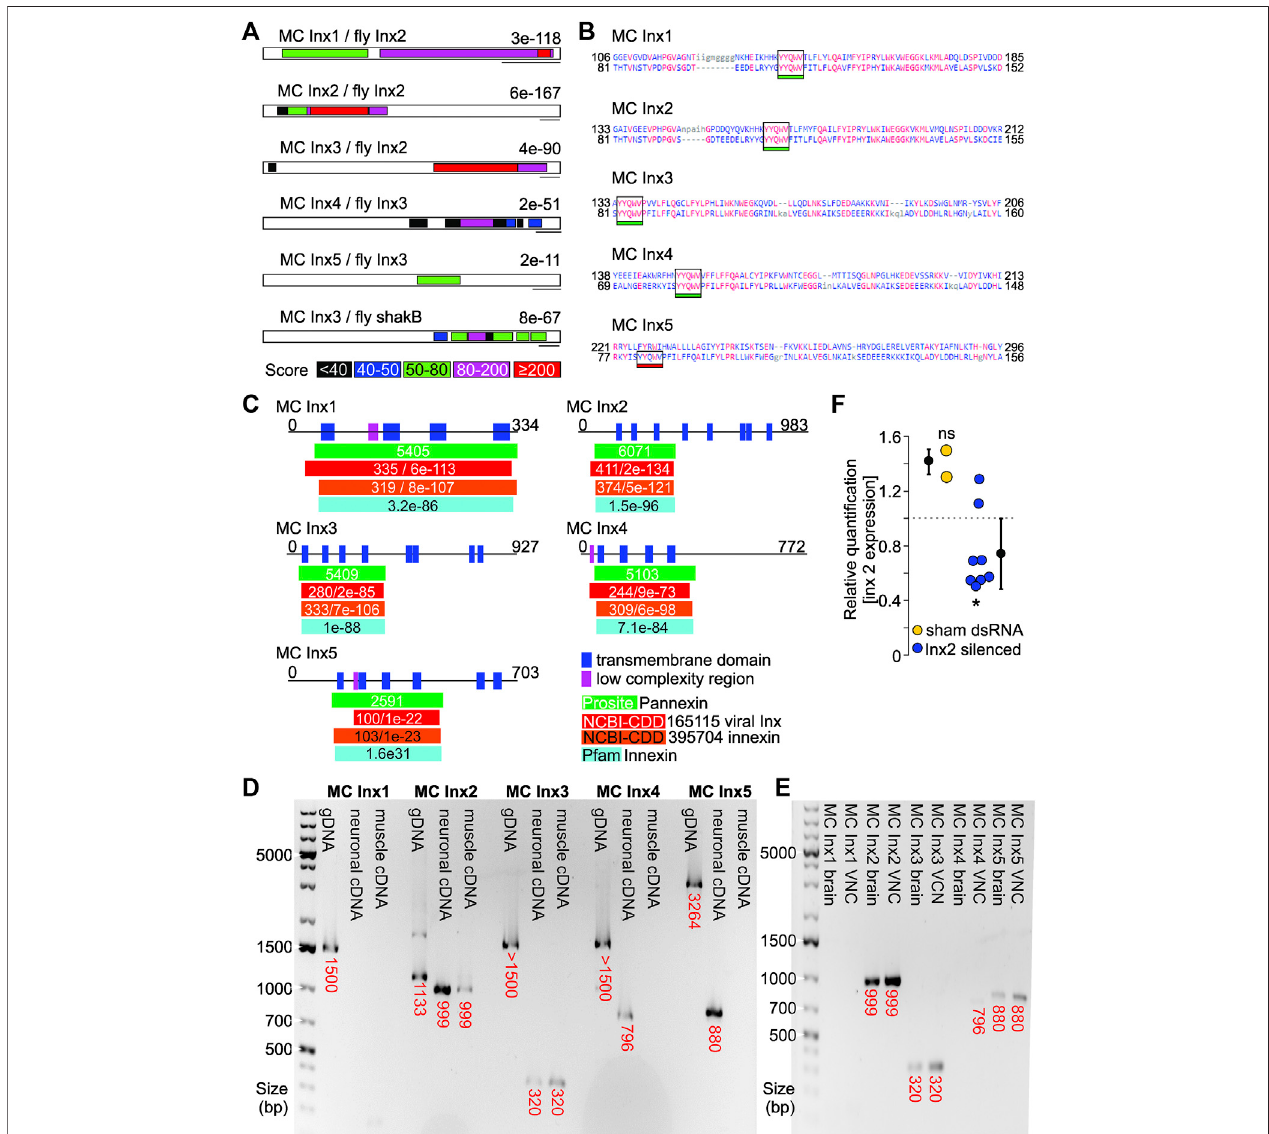
FIGURE 2 | (A) Blast comparison of marbled cray fi sh (MC) putative innexin transcripts and identi fi ed innexins from Drosophila melanogaster . E-values are given. Colors indicate score. Scale bars: 200 bp. (B) Amino acid projection of putative MC innexins (top) and innexin amino acid sequences of a domain model from other species (bottom). MC innexins 1-4 are predicted to contain the innexin hallmark YYQWV amino acid sequences. (C) Motif and domain prediction of putative MC innexin aminoacidsequences. All fi veinnexins containtransmembranedomains andinclude known innexinmotifs intheir aminoacidsequence (colored bars). (D) and (E) Gel electrophoresis of innexin sequences ampli fi ed using intron spanning PCR primers. (D) Innexins 2-5 had abundant expression in neuronal tissue. Innexins 2 and 3 were additionally expressed in muscle tissue. mRNA was extracted from neuronal tissue (brain, abdominal, and thoracic ganglia) and from abdominal muscles, respectively. (E) Innexins 2, 3, and 5 showed abundant expression in the brain. Innexins 2, 3, 4, and 5 were expressed in the ventral nerve cord. (F) RNAi-induced reductionofMCinnexin2,2 daysaftertreatmentwithdsRNA.ScrambleddsRNAwasused forshaminjections.* p < 0.05,ns=notsigni fi cant,onesamplet-testagainst housekeeping gene (EIF- α